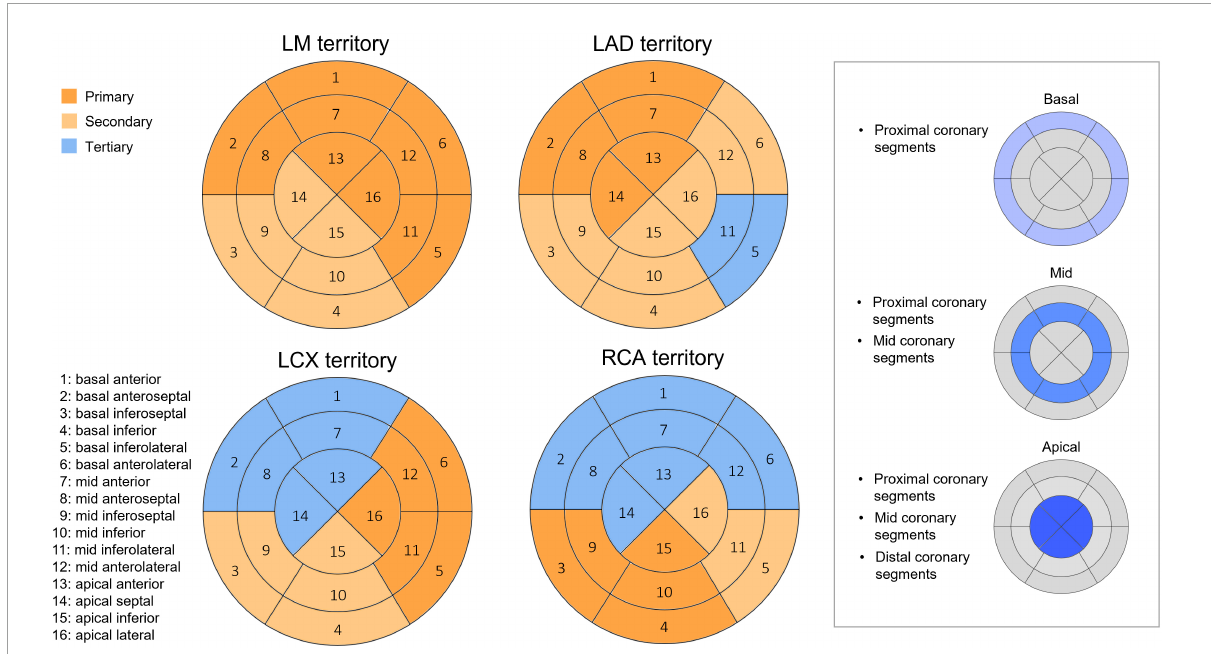
FIGURE2 Integration of coronary anatomy and myocardial territories. Vessel territories were defined based on the modified method after Cerci et al. for LM, LAD, LCX, and RCA. The following categories were determined for myocardial segments: primary—most commonly supplied territories in case of right dominance; secondary—might be supplied territories in case of normal variations; tertiary—usually not supplied territories. In addition, coronary segment-based analysis was also used, taking lesion location into account. For that, basal segments were aligned with proximal, mid segments with proximal and mid, and apical segments with proximal, mid and distal coronary segments. LAD, Left anterior descending; LCX, Left circumflex; LM, Left main; RCA, Right coronary